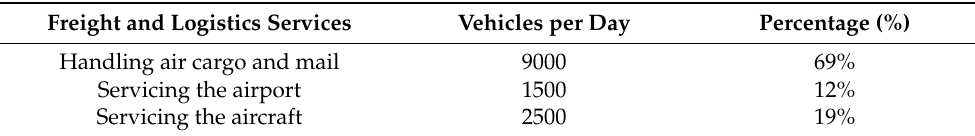
Table 3. Freight and logistics services at Heathrow Airport—surface access modes in 2018 (Source: Adapted from Heathrow Airport Limited (2018)